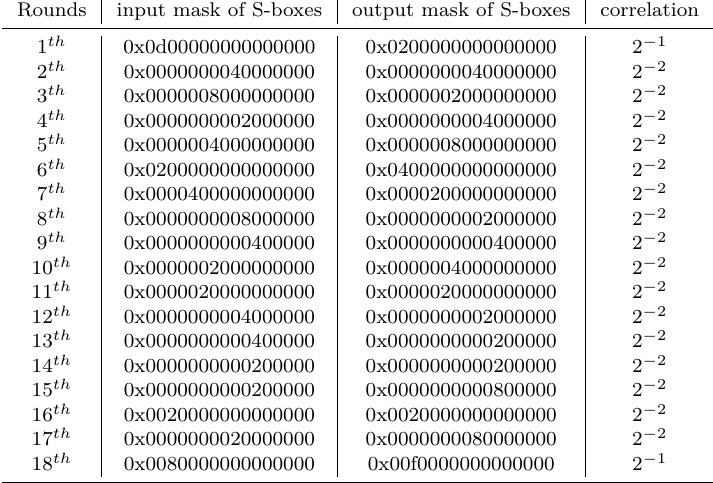
Table 9: The best linear characteristic with correlation 2 − 34 for 18-round